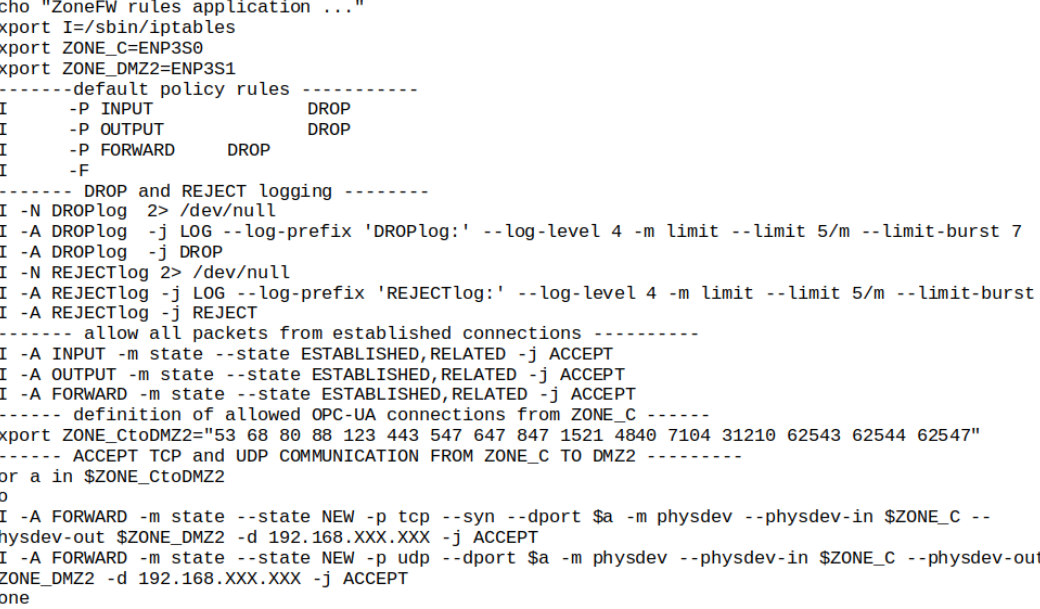
Figure 16. Example of a stateful firewall implementation in Linux OS.